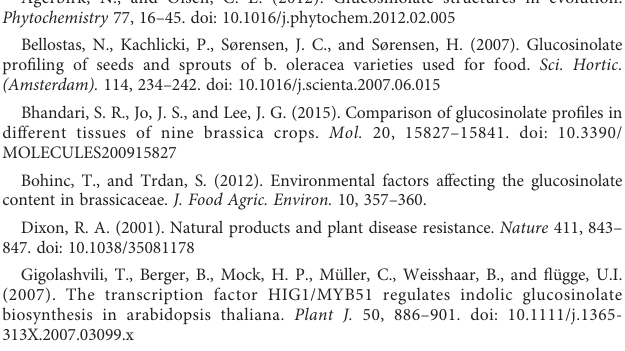
SUPPLEMENTARY FIGURE 6 Integrative genome browser (IGV) illustration of the expression pro fi les of 19 total indolic GSL biosynthetic genes between ‘ Chiifu ’ and ‘ LP08 ’ grown under light and dark conditions. (A) IGV illustration of the expression pro fi les of fi ve genes involved in the ‘ core structure formation ’ stage of indolic GSL biosynthesis. Normalized read counts for each gene are indicated by black, brown, blue, and green colors for ‘ Chiifu ’ grown in the dark, ‘ LP08 ’ grown in the dark, ‘ Chiifu ’ grown in the light, and ‘ LP08 ’ grown in the light, respectively. Read coverage normalized to the total number of mapped reads is indicated in parentheses at the top left corner of each track. (B) IGV illustration of the expression pro fi les of six genes commonly involved in the ‘ core structure formation ’ stages of both aliphatic and indolic GSL biosynthesis. Normalized read counts for each gene are indicated by black, brown, blue, and green colors for ‘ Chiifu ’ growninthedark, ‘ LP08 ’ growninthedark, ‘ Chiifu ’ growninthelight, and ‘ LP08 ’ grown in the light, respectively. Read coverage normalized to the total number of mapped reads is indicated in parentheses at the top left corner of each track. (C) IGV illustration of the expression pro fi les of four genes involved in the ‘ secondary modi fi cation ’ stage of indolic GSL biosynthesis. Normalized read counts for each gene are indicated by black, blue, brown, and green colors for ‘ Chiifu ’ grown in the dark, ‘ LP08 ’ grown in the dark, ‘ Chiifu ’ grown in the light, and ‘ LP08 ’ grown in the light, respectively. Read coverage normalized to the total number of mapped reads is indicated in parentheses at the top left corner of each track. (D) IGV illustration of the expression pro fi les of four genes involved in the ‘ breakdown ’ stage of indolic GSL catabolism. Normalized read counts for each gene are indicated by black, blue, brown, and green colors for ‘ Chiifu ’ grown in the dark, ‘ LP08 ’ grown in the dark, ‘ Chiifu ’ grown in the light, and ‘ LP08 ’ grown in the light, respectively. Read coverage normalized to the total number of mapped reads is indicated in parentheses at the top left corner of each track. SUPPLEMENTARY FIGURE 7 Results of QTLmapping of 97 F 5 RILs andparental linesusing HPLC data for GSL contents under long-day conditions. (A) Results of QTL mapping for total GSLs, total indolic GSLs, and total aliphatic GSL. (B) Results of QTL mapping for individual aliphatic GSL compounds. X-axis represents the chromosomes (in order), and the Y-axis represents the limit of detection (LOD). AlP and Ind means aliphatic GSL and indolic GSL. The red and blue asterisks indicate peaks at the same position, respectively. SUPPLEMENTARY FIGURE 8 Expression pro fi le of 77 DEGs (55 up- and 24 down-regulated genes under light and dark condition. (A) Expression heatmap of 55 ‘ LP08 ’ -upregulated GSL pathway genes under light and dark condition. A majority of 55 ‘ LP08 ’ up- regulated genes were signi fi cantly downregulated in both ‘ Chiifu ’ and ‘ LP08 ’ dark samples. Downregulated genes in dark condition were indicated with right side blue vertical bar. Upregulated genes in the dark condition were indicated with right side red vertical bar. (B) Expression heatmap of 24 ‘ LP08 ’ - downregulated GSL pathway genes under light and dark condition. Many of 24 ‘ LP08 ’ -downregulated genes were not signi fi cantly affected in the absence of light, less sensitively affected in the dark condition when compared to the expression pro fi le of 55 ‘ LP08 ’ up-regulated